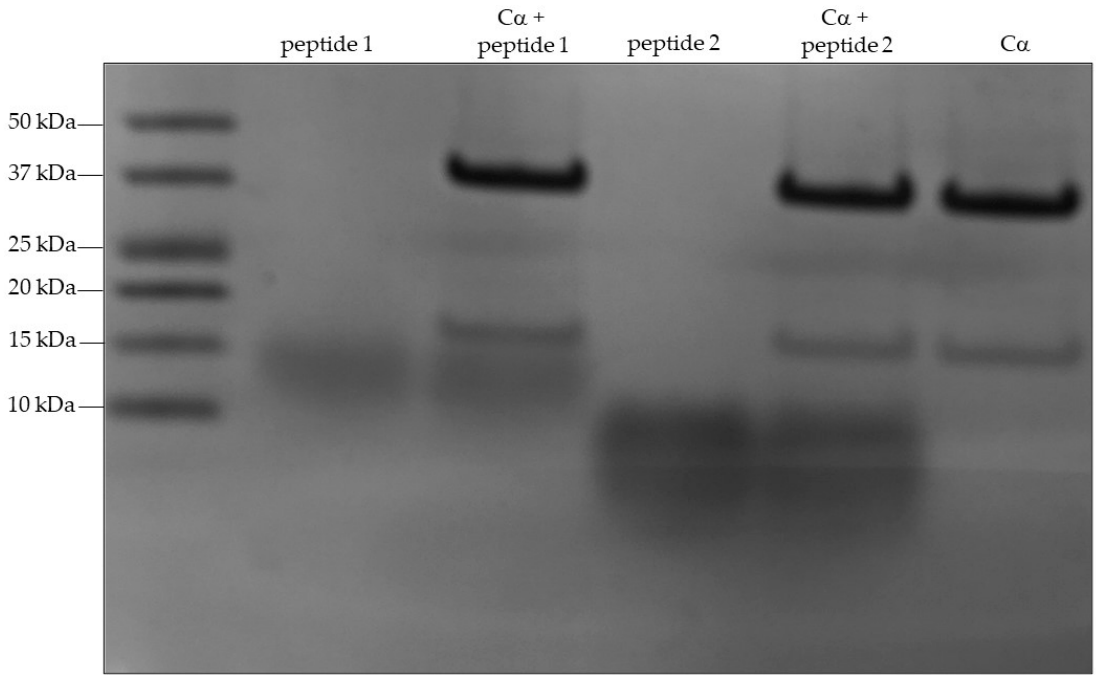
Figure 2. Coomassie staining of peptide 1, peptide 2, and the catalytic subunit of PKA. Five mg peptide was incubated with PKA for 30 min and thereafter run on an acryl amide gel. Proteins were stained with Coomassie blue. The molecule mass marker is shown (in kDa).